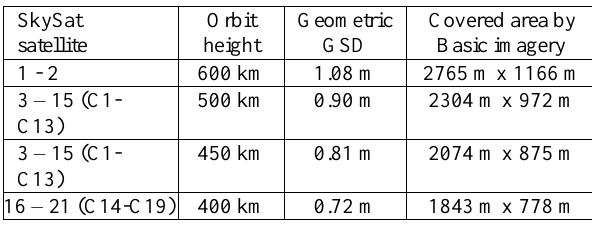
Table 1: Geometric ground sampling distance and area covered by SkySat Basic imagery as a function of flight altitude for the nadir view direction Table 1 is based on a pixel size of 6.5 µm and 2560 x 2160 pixels. The GSD and the area covered are confirmed by the data sets used. As previously mentioned, in June 2020, SkySat-3 to - 13 reduced the orbital altitude from 500 km to 450 km. The image sharpening by the digital TDI is used for a so-called super-resolution, which reduces the GSD of the generated SkySat Basic Panchromatic.